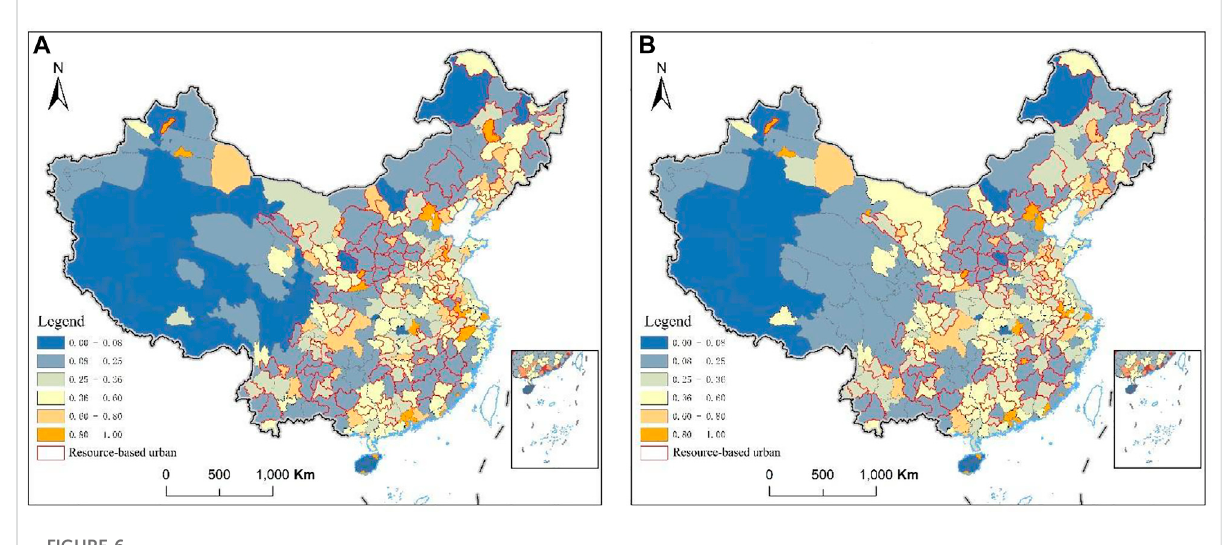
FIGURE 6 Spatial concentration of central urban areas in China. (A) 2000; (B)